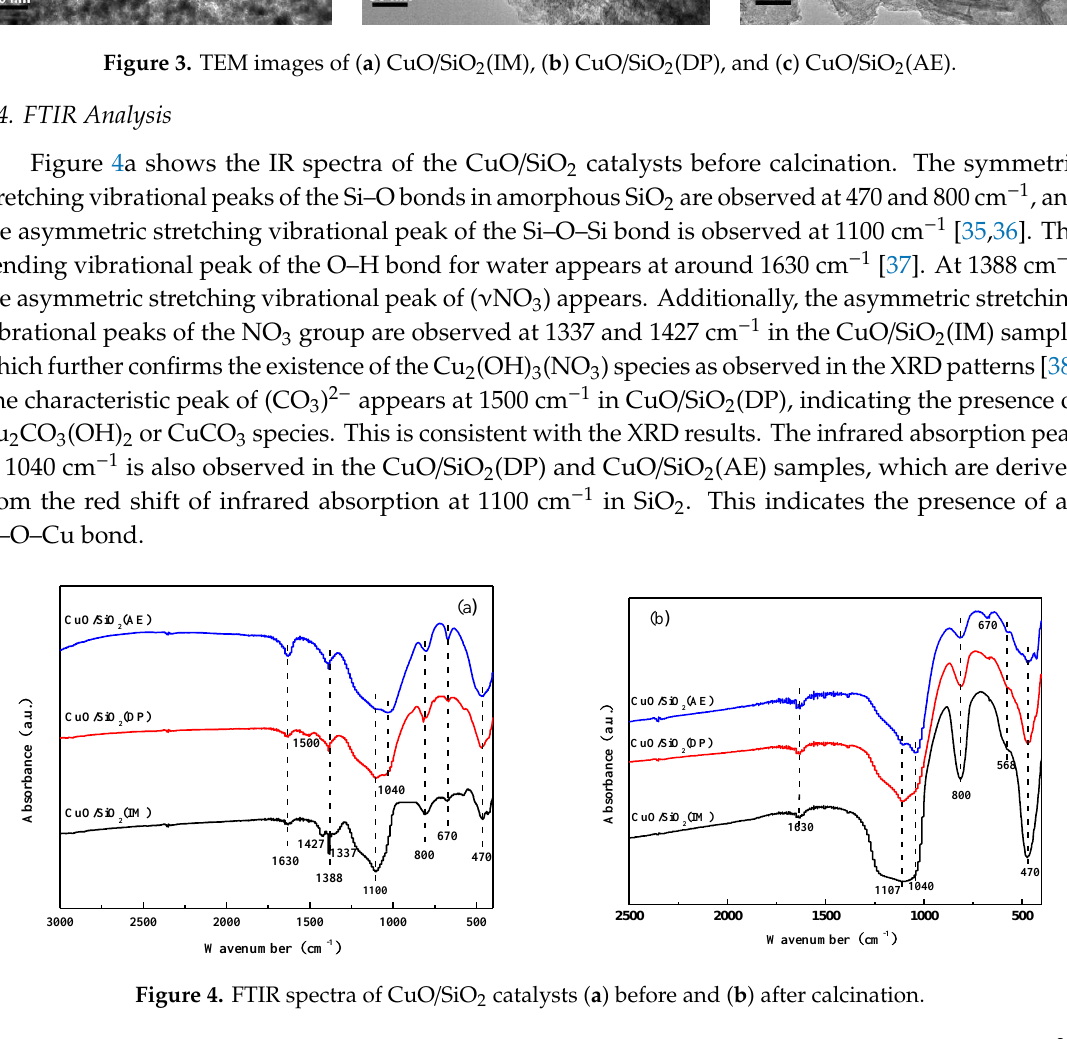
Figure 4. FTIR spectra of CuO/SiO 2 catalysts ( a ) before and ( b ) after calcination.